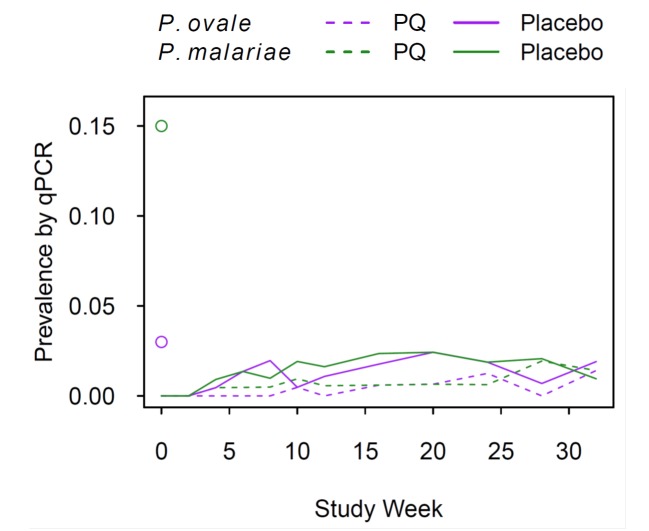
P. ovale and P. malariae prevalence by qPCR during follow-up.Purple lines, P. ovale; green lines, P. malariae; solid lines, Placebo arm; dashed lines, PQ arm. Open circles mark enrolment qPCR prevalence for each species.